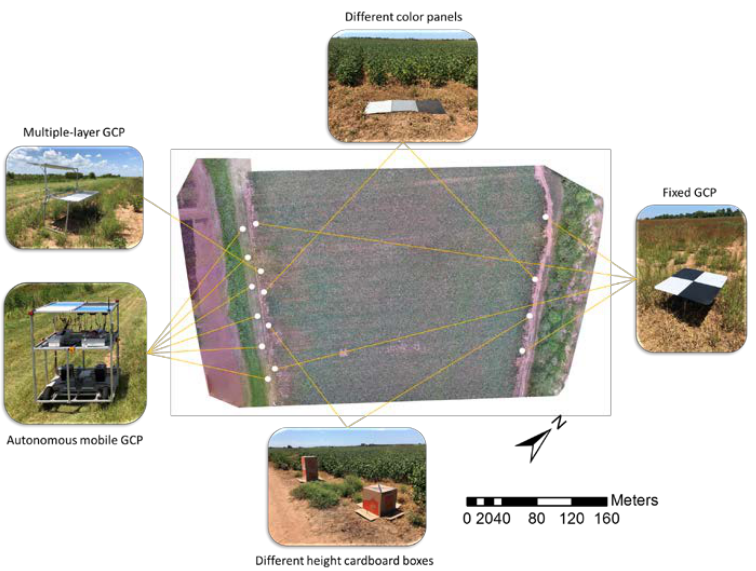
Figure 6. Distribution of the autonomous mobile GCP, multi-level GCP, fixed GCP, and validation objects at the experiment field at Texas A&M AgriLife Research Farm.